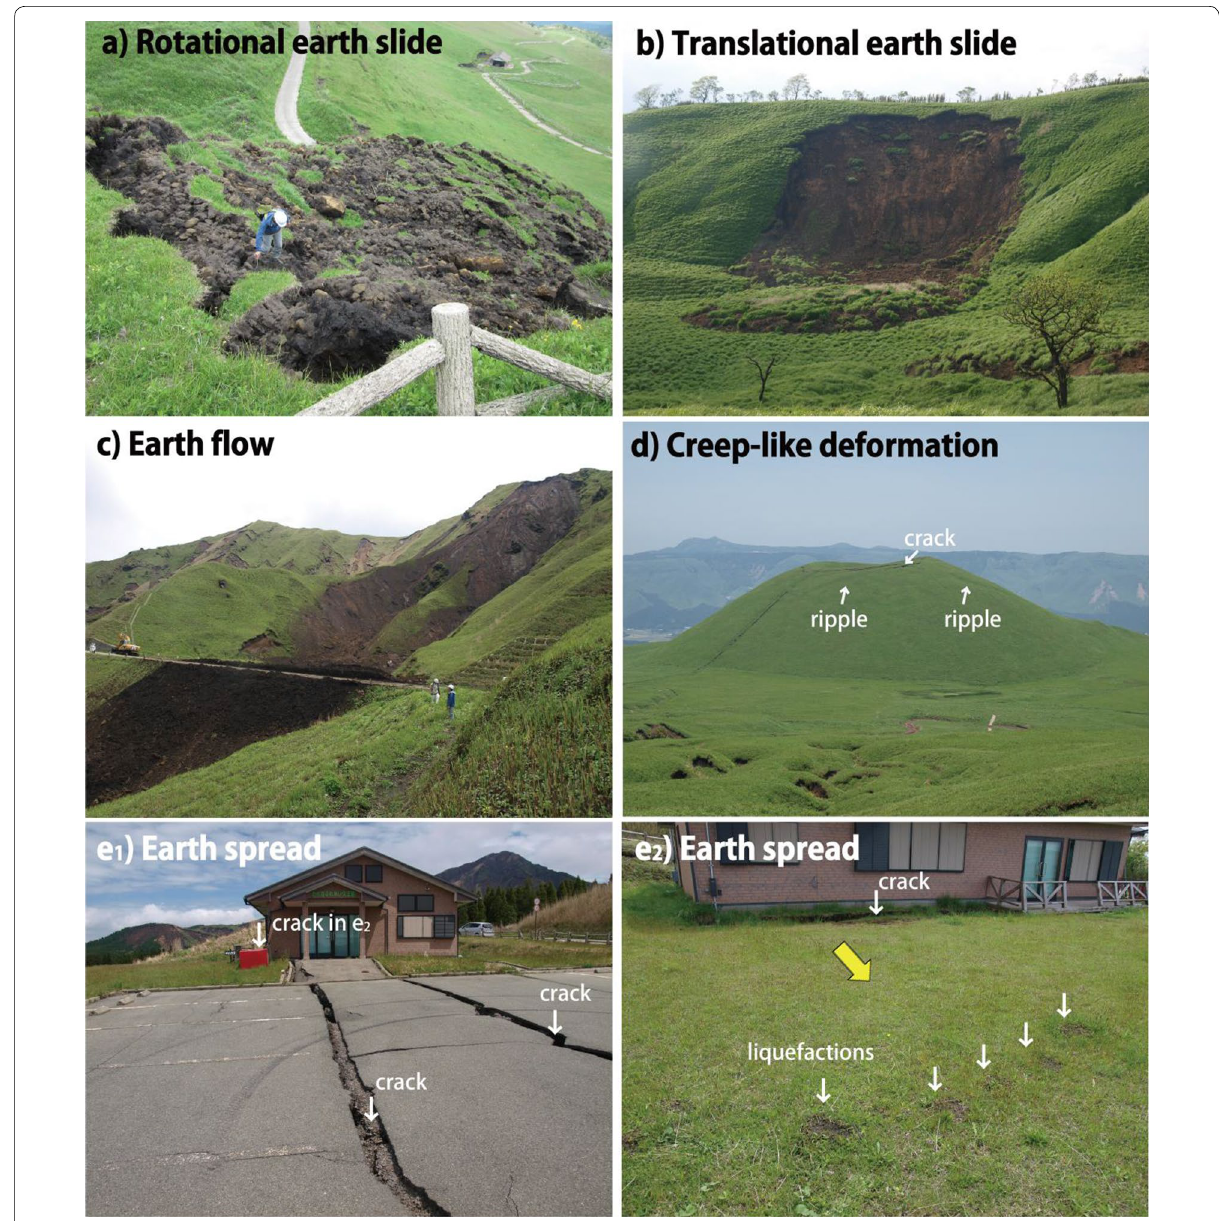
Fig. 3 Landslide type composed predominantly of fine deposits on the Aso volcanic edifice. a Rotational earth slide on Yomineyama volcano; b translational earth slide on Janoo scoria cone; c earth flow on the western flank of Okamadoyama volcano; d creep-like deformation on Komezuka volcano (scoria cone); e 1 , e 2 earth spread in Yomineyama volcano including some liquefaction